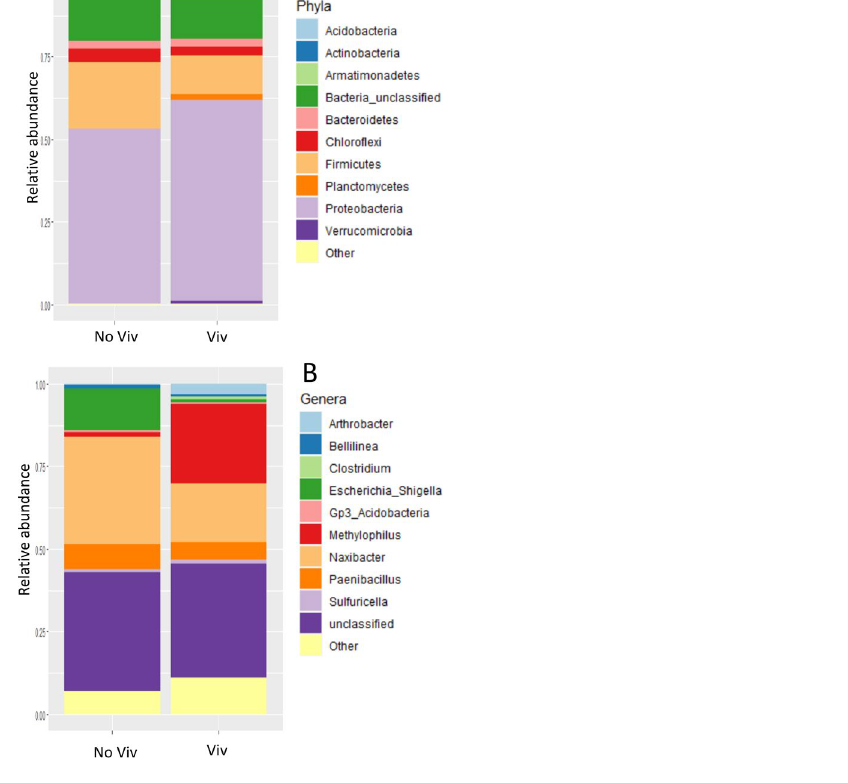
Figure 5. Relative abundance of bacterial phyla ( A ) and genera ( B ) within samples showing visible vivianite (Viv) or no visible vivianite (No Viv). Replicates are averaged. The ten most abundant phyla/genera are shown with the remainder shown as